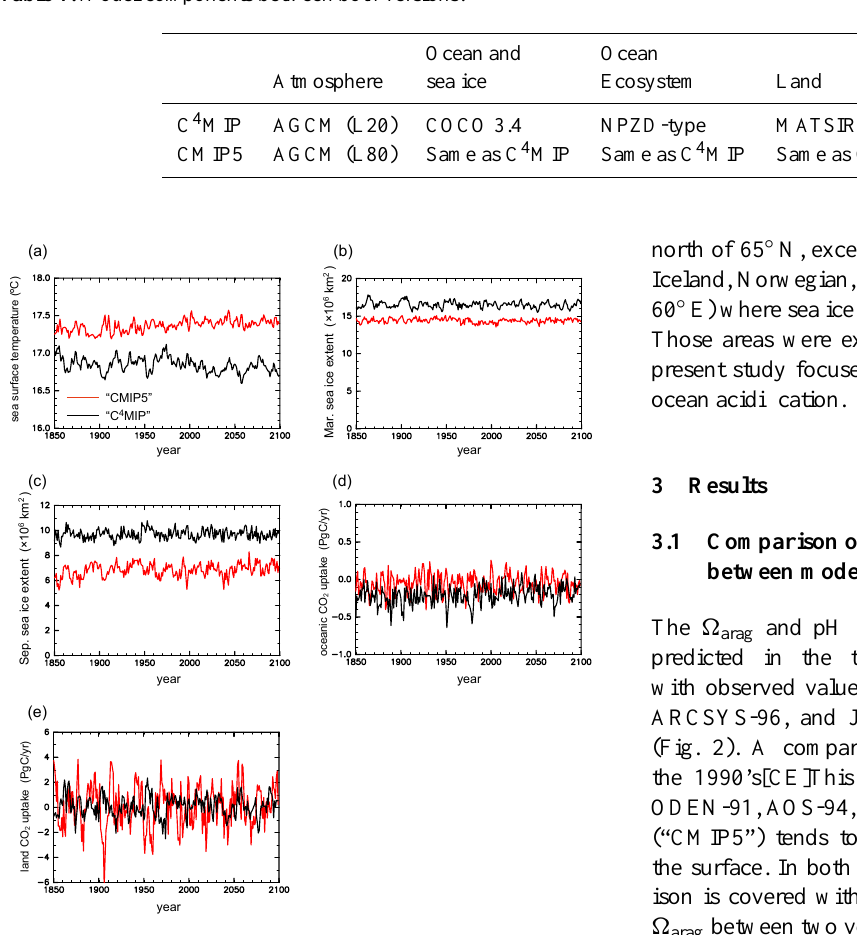
Table 1. Model components between both versions.